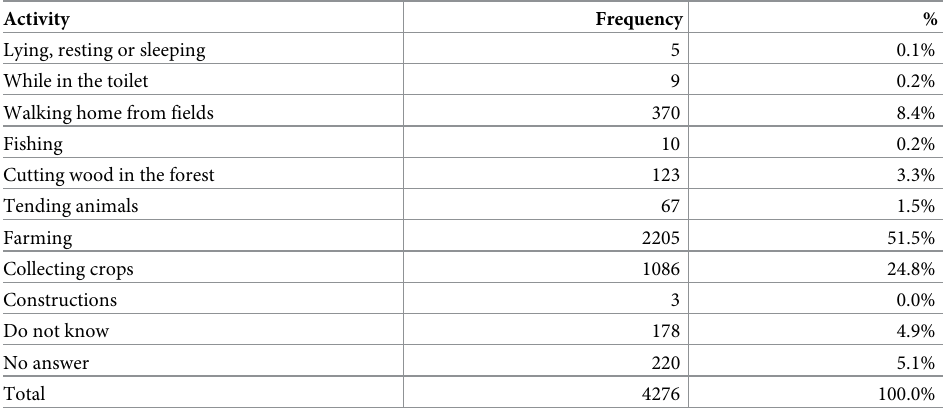
Table 5. Activities most associated with people getting